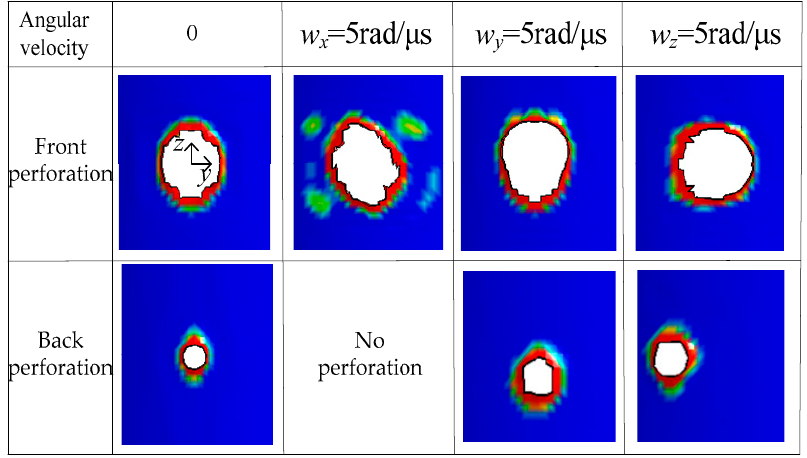
Figure 13. Front and back perforations caused by the debris impacting the satellite tank with angular velocities of w x = 5 rad/ μ s, w y = 5 rad/ μ s, and w z = 5 rad/ μ s.